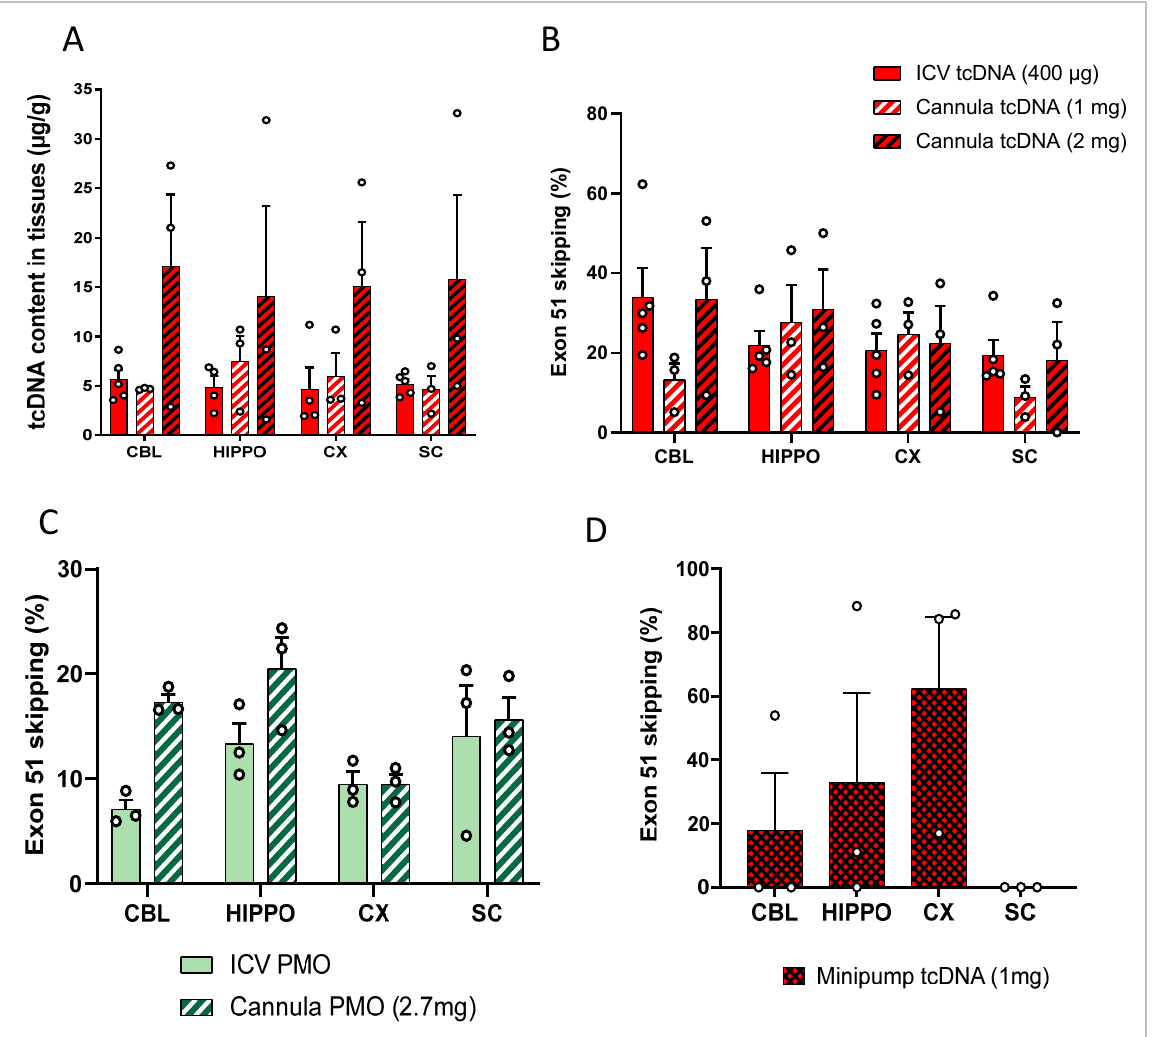
Figure 2. Repeated ICV delivery of tcDNA and PMO. ( A ) Quantification by fluorescent hybridization assay of tcDNA-Ex51 content in various CNS tissues after three multiple injections via a cannula implant 4 weeks after tcDNA administration. Results are expressed as means ± SEMs; n = 3 mdx52 - tcDNA-Ex51 in cannula groups. ( B ) Quantification of exon 51-skipping levels via RT-qPCR in different brain tissues. Results are expressed as means ± SEMs; n = 3 mdx52 -tcDNA-Ex51 in cannula groups. ( C ) Quantification of exon 51-skipping levels via RT-qPCR in different brain tissues 7 weeks after either single ICV slow-bolus injection or three administrations via a cannula implant of PMO. ( D ) Quanti fi cation of exon 51-skipping levels via RT-qPCR in di ff erent brain tissues after very slow di ff usion via osmotic pumps of tcDNA. CBL: cerebellum, CX: cortex, HIPPO: hippocampus, and SC: spinal cord (cervical region). Results are expressed as means ± SEMs; n = 3 mdx52 -minipump- tcDNA-Ex51.